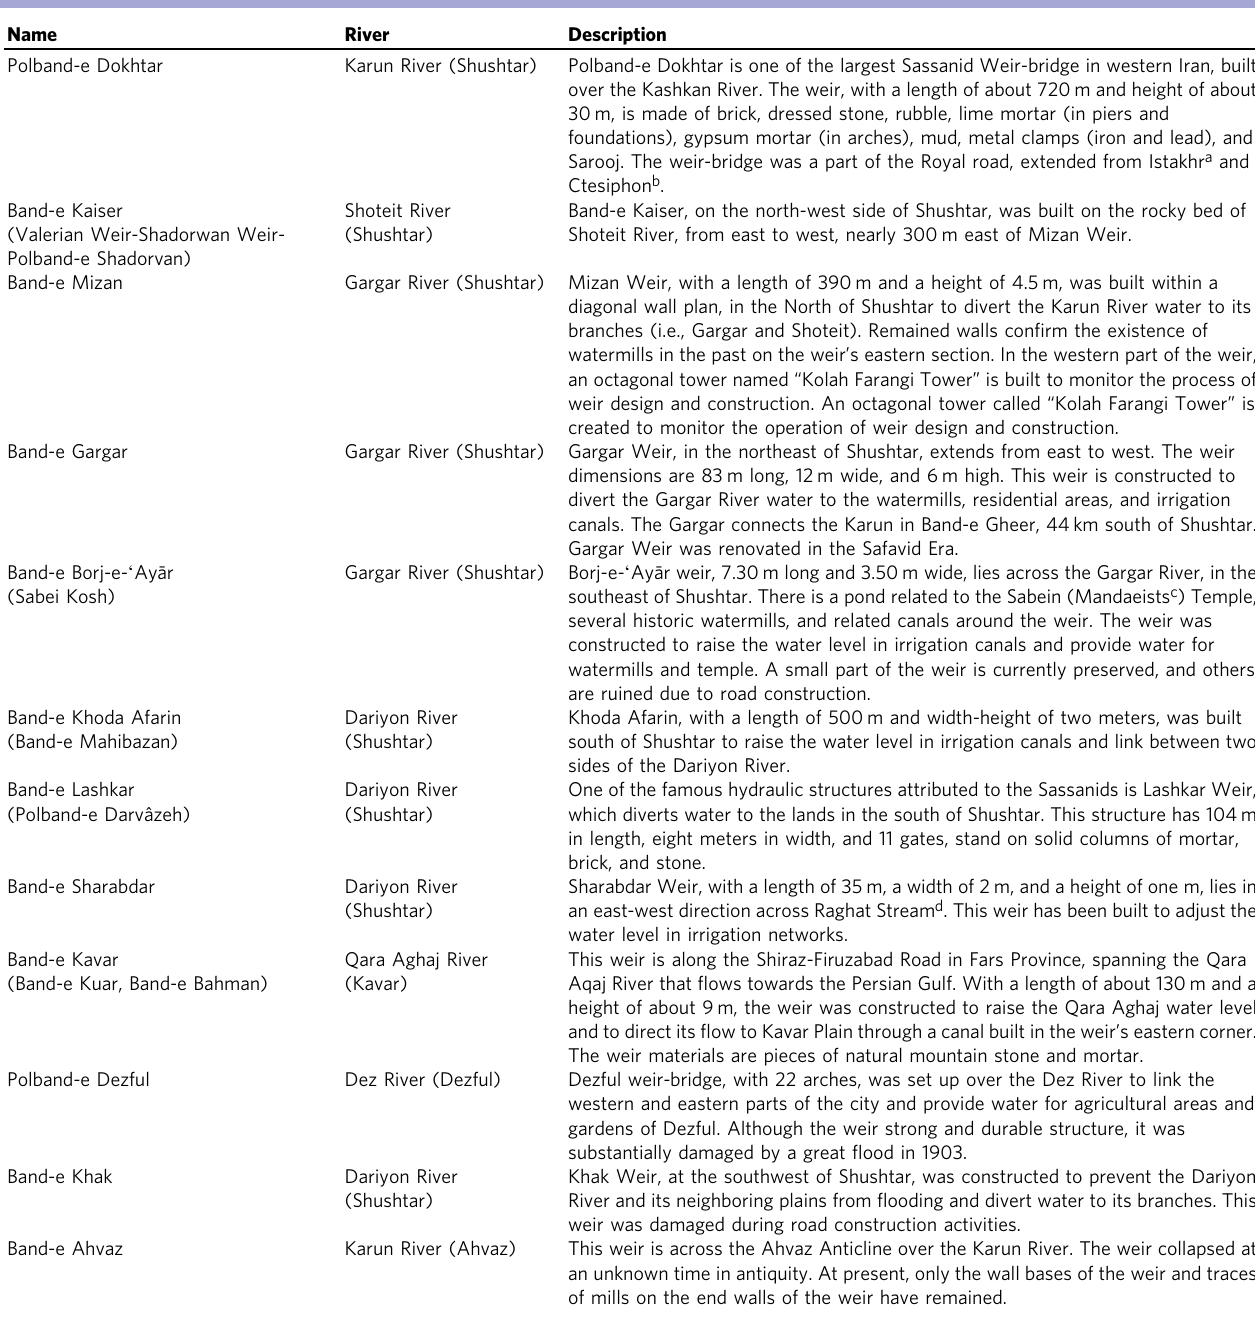
Table 2 List of dams (weirs) constructed by the